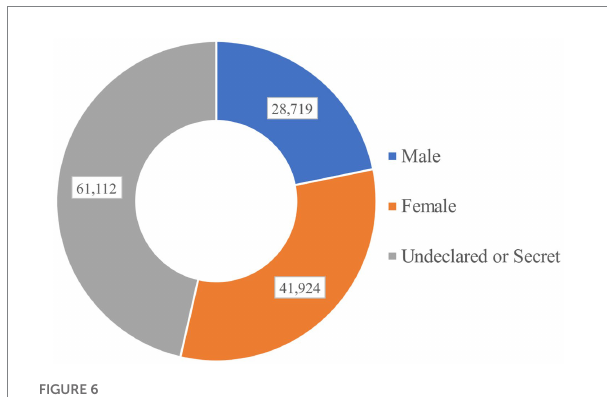
FIGURE 6 The gender distribution of the posters on